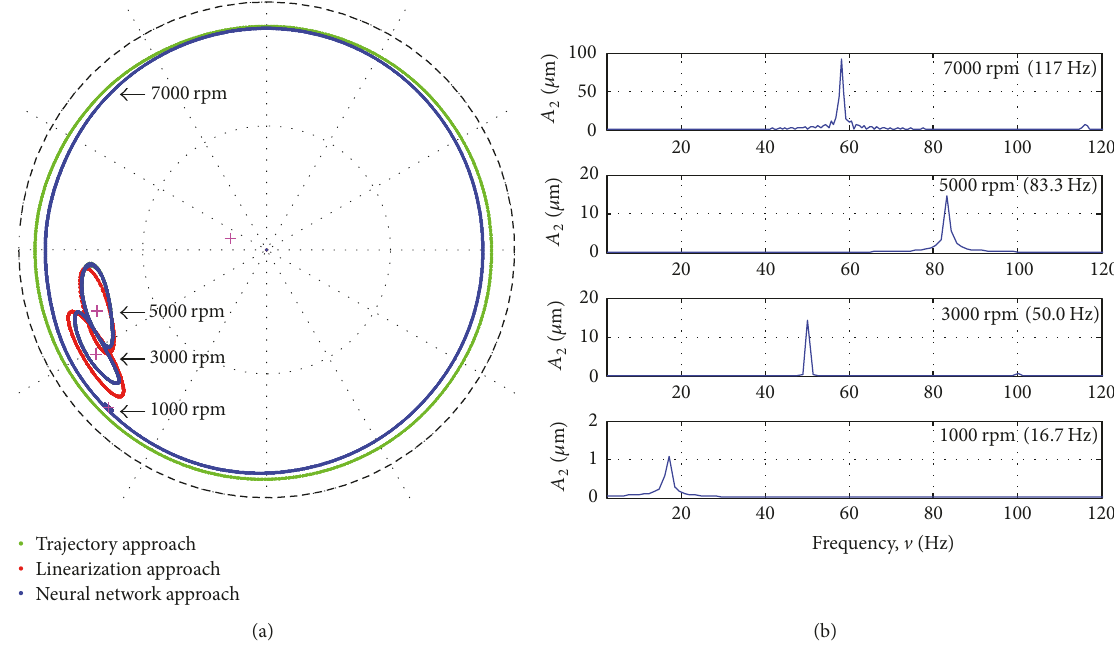
Figure 6: Comparative results of rotor’s vibrations calculation (a) and frequency responses at various rotation speed in a 1000, . .. ,7000 rpm